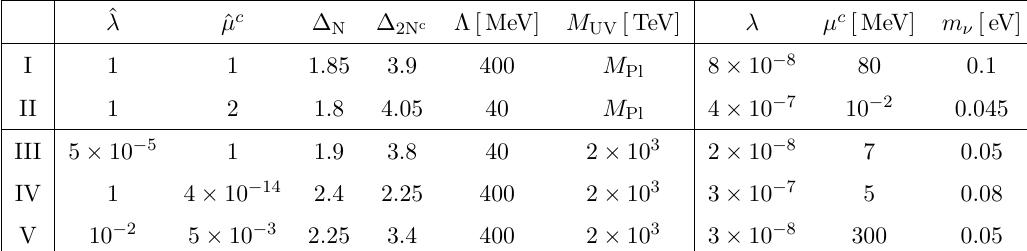
Table 1 . Some representative choices of parameters that lead to neutrino masses of parametrically the right size. Shown are the dimensionless couplings ˆ λ and ˆ µ c , the scaling dimensions ∆ and ∆ , N 2N c the compositeness scale Λ , and the cutoff scale M . Also shown are some derived parameters, in UV particular the coupling constant λ , the Majorana mass term for the composite singlet neutrinos µ c , and the resulting mass scale of the light neutrinos. For each set of parameters all the constraints outlined in the paper are satisfied. In the upper set of benchmarks, the smallness of the neutrino masses is fully explained by the running of parameters from the Planck scale cutoff down to the infrared. In the lower set of benchmarks, the ultraviolet cutoff is lowered to 2 PeV, and the light masses of the neutrinos are explained, at least in part, by